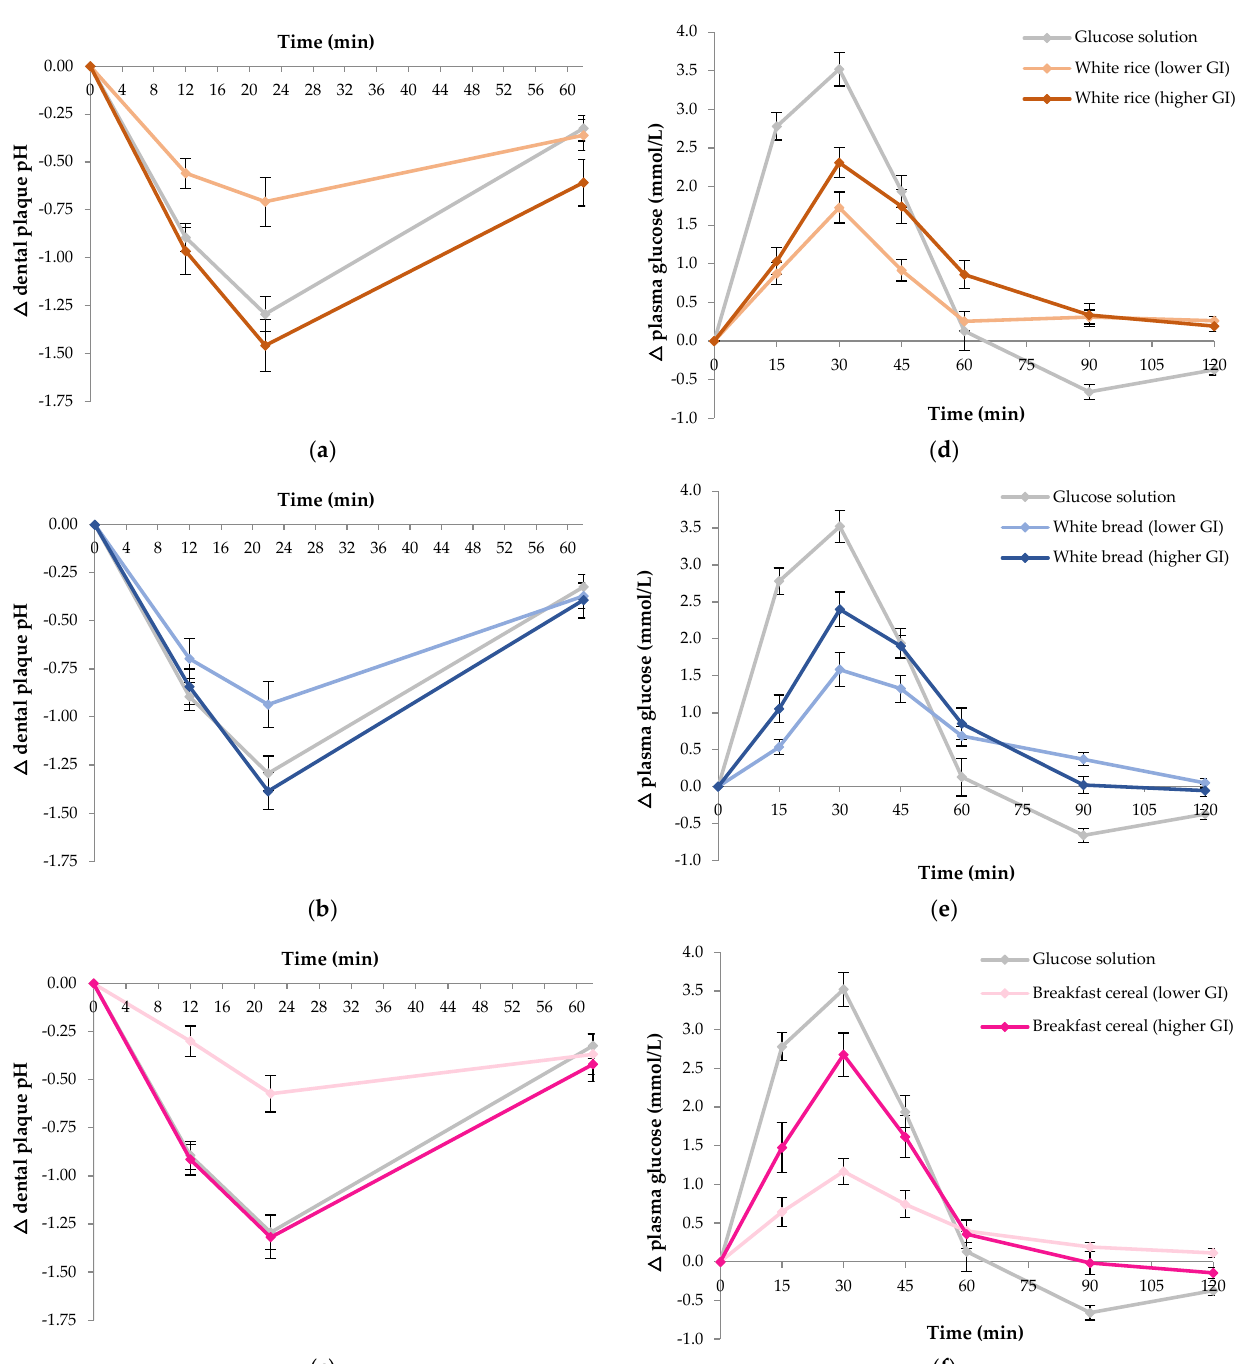
Figure 3. Impact of 25 g available carbohydrate portions of different carbohydrate food pairs, varying in GI, on dental plaque pH in 12 healthy participants ( a ) Change in postprandial dental plaque pH over 62 min following consumption of a lower GI rice (shown in pale orange) and a higher GI rice (shown in dark orange); ( b ) Change in postprandial dental plaque pH over 62 min following consumption of a lower GI white bread (shown in pale blue) and a higher GI white bread (shown in dark blue); ( c ) Change in postprandial dental plaque pH over 62 min following consumption of a lower GI breakfast cereal (shown in pale pink) and a higher GI breakfast cereal (shown in dark pink); ( d ) Change in plasma glucose concentration over 120 min following consumption of two types of rice varying in GI; ( e ) Change in plasma glucose concentration over 120 min following consumption of two breads varying in GI; ( f ) Change in plasma glucose concentration over 120 min following consumption of two breakfast cereals varying in GI. Data are mean ± standard error mean (SEM), n = 24 for the two repeated glucose solution tests (shown in pale grey), and n = 12 for each test